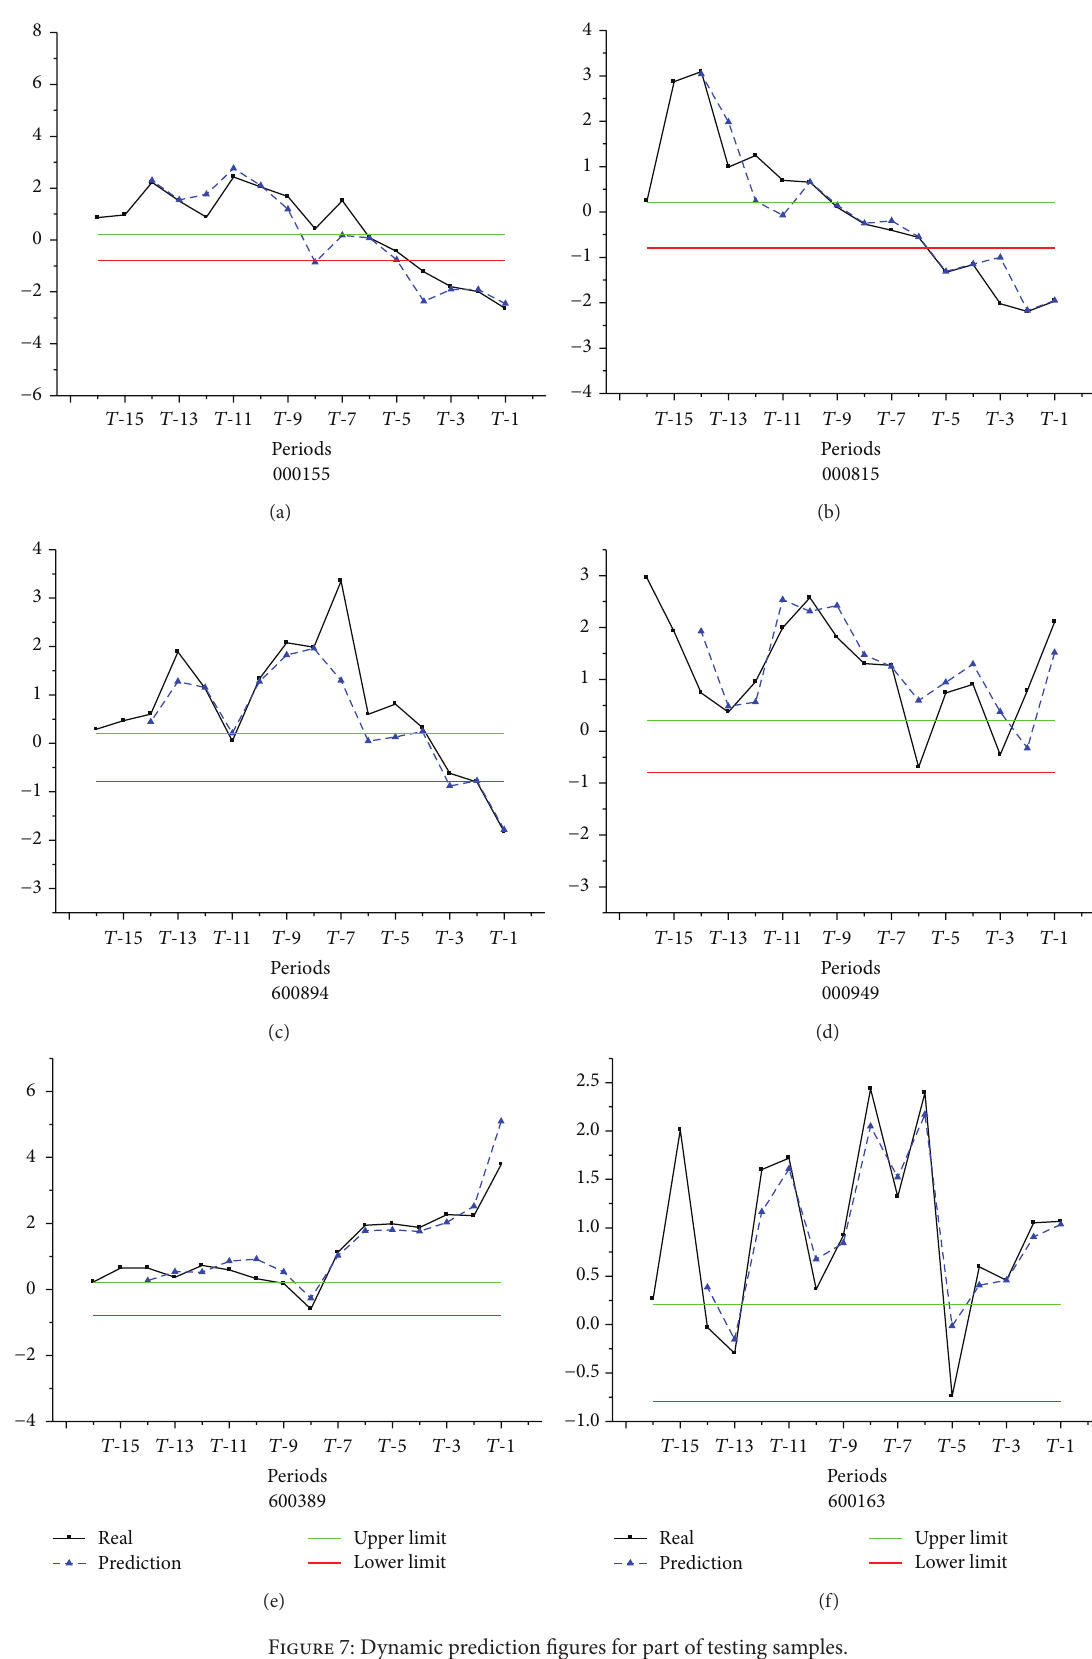
Figure 7: Dynamic prediction figures for part of testing